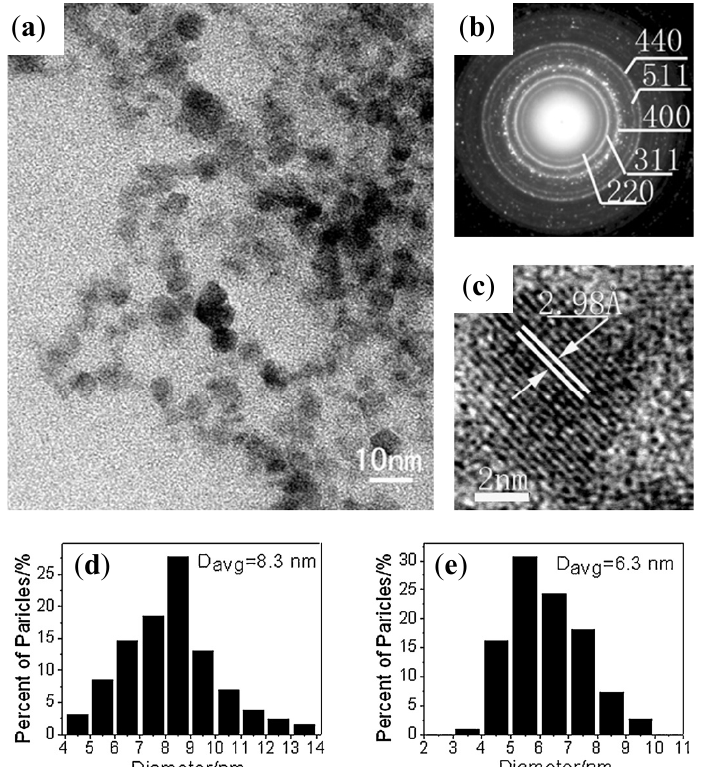
Figure 31. ( a ) TEM image; ( b ) SAED pattern for magnetic Fe coprecipitation of iron salts within polymer disk; ( c ) typical HRTEM image for a single O NP, and size distribution of the Fe Fe 3 4 at: ( d ) 0.46 mol% and ( e ) 6.14 mol%. Reprinted with permission from [56]. Copyright 2011 Elsevier